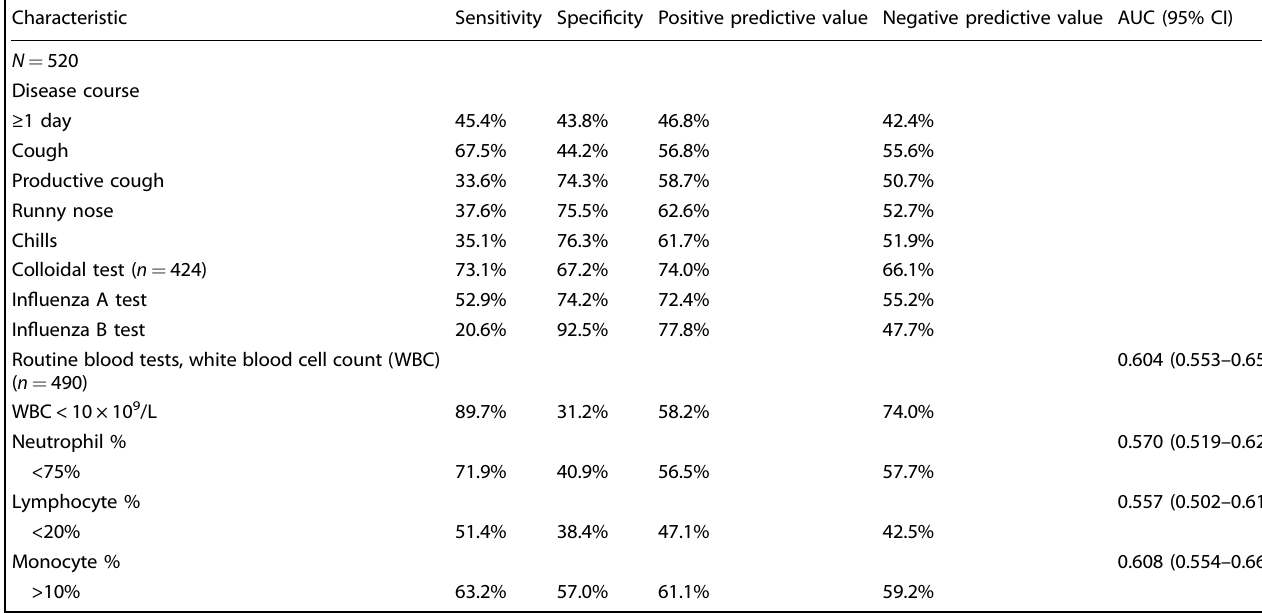
Table 3. Diagnostic performance of clinical characteristics associated with a de fi nitive diagnosis of in fl uenza.